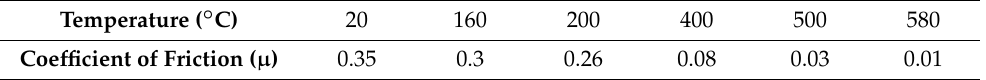
Table 1. Temperature-dependent Coulomb’s friction coefficient used in the numerical model